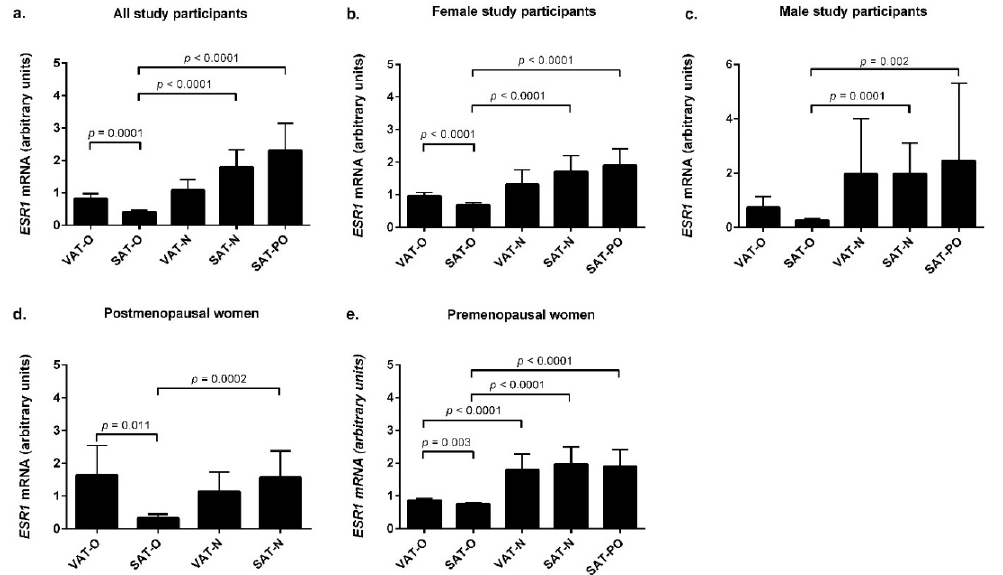
Figure 1. ESR1 mRNA levels in the visceral (VAT) and subcutaneous (SAT) adipose tissues of the obese individuals before (O) and after surgically induced weight loss (PO) and in the normal-weight subjects (N). Results are presented as the median with the interquartile range for the whole group ( a ), women ( b ), men ( c ), postmenopausal women ( d ), and premenopausal women ( e ).